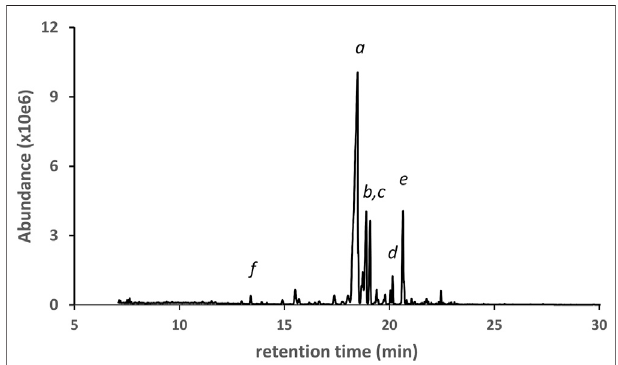
FIGURE6 | GC-MSchromatogram fora cannabis vaping liquid inwhich the predominant cannabinoid was d8THC( a ). d9THC( b ), d6a,10aTHC( c ), 6aR,9R-d10THC( d ), 6aR,9S-d10THC( not labeled ), and exoTHC( not labeled ) were also found. Other cannabinoids: CBN( e ) and d8THCV( f